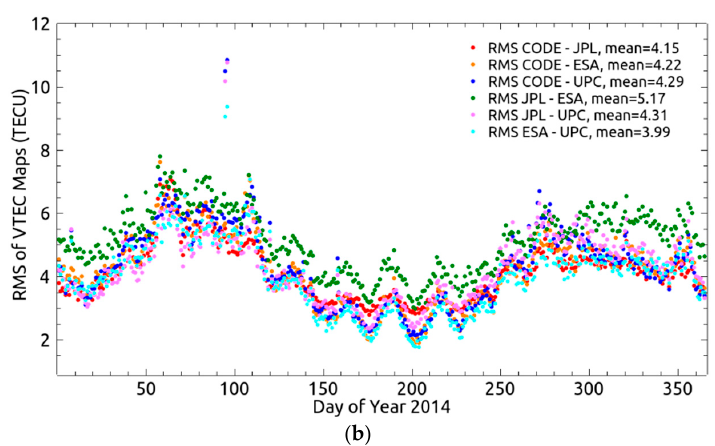
Figure 2. Differences in VTEC maps among IAAC products in 2014. ( a ) Biases of global vertical total electron content (VTEC) maps comparisons among Ionosphere Associate Analysis Center (IAAC) products. ( b ) Root Mean Square (RMS) of differences in VTEC maps among IAAC products.